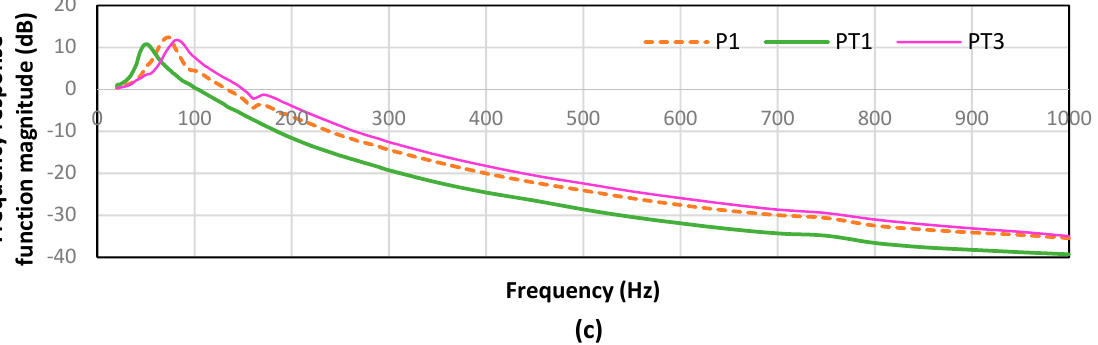
Figure 4. Vibration transmissibility of fabric samples that show the effect of: ( a ) spacer yarn, ( b ) inlay pattern and ( c ) inlay materials.